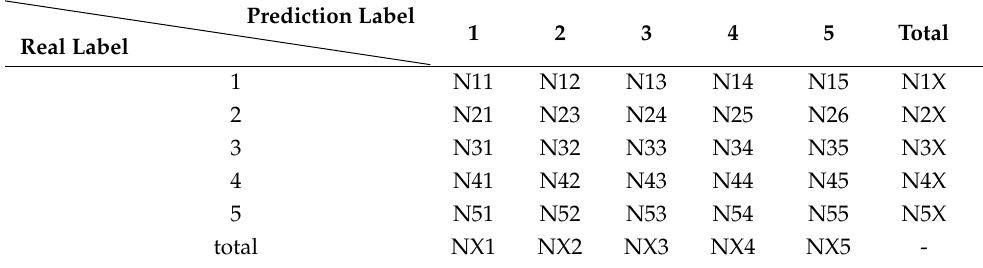
Table 2. Confusion